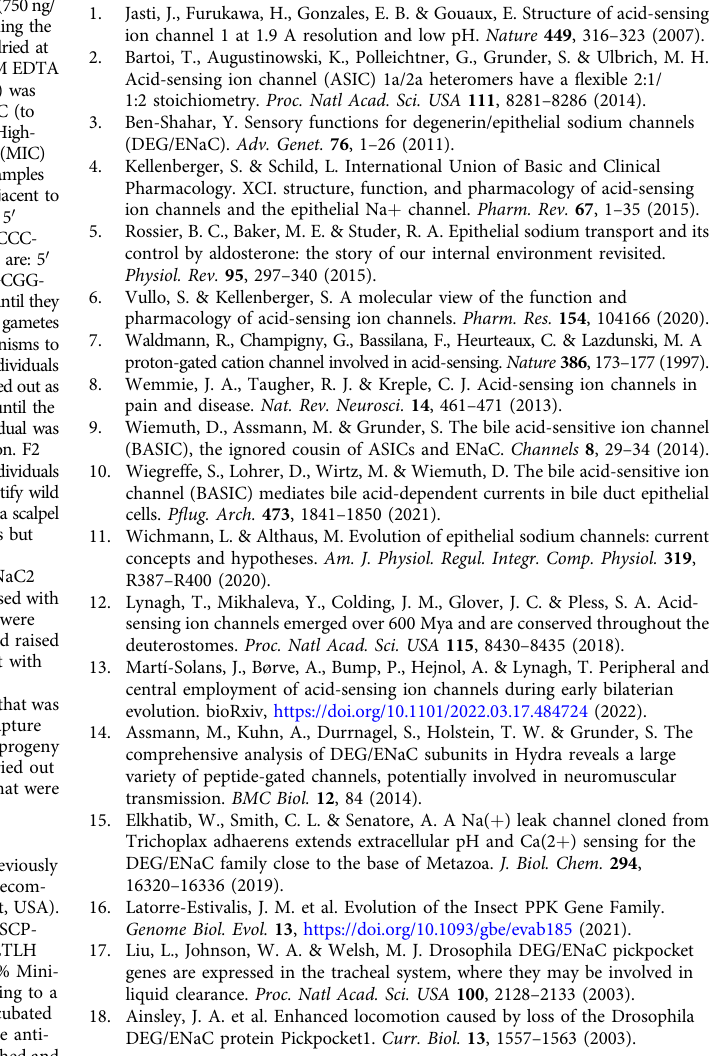
NvNcol3::mOrange2 positive and NeNaC2 heterozygous were identi fi ed and raised until they reached sexual maturity. One F1 heterozygous NeNaC2 mutant with NvNCOl3:mOrange2 background was crossed with another individual F1 heterozygous NeNaC2 having the same mutation. F2 progeny of this cross that was mOrange2 positive were selected and individually genotyped. The prey capture experiment (as above) was carried out for the three genetic pools of the F2